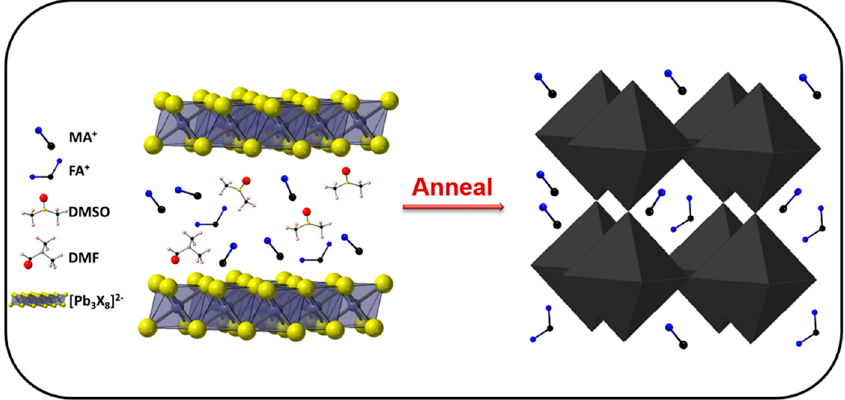
Figure 4. Schematic illustration of the intermediate phase ( left ) and perovskite phase ( right